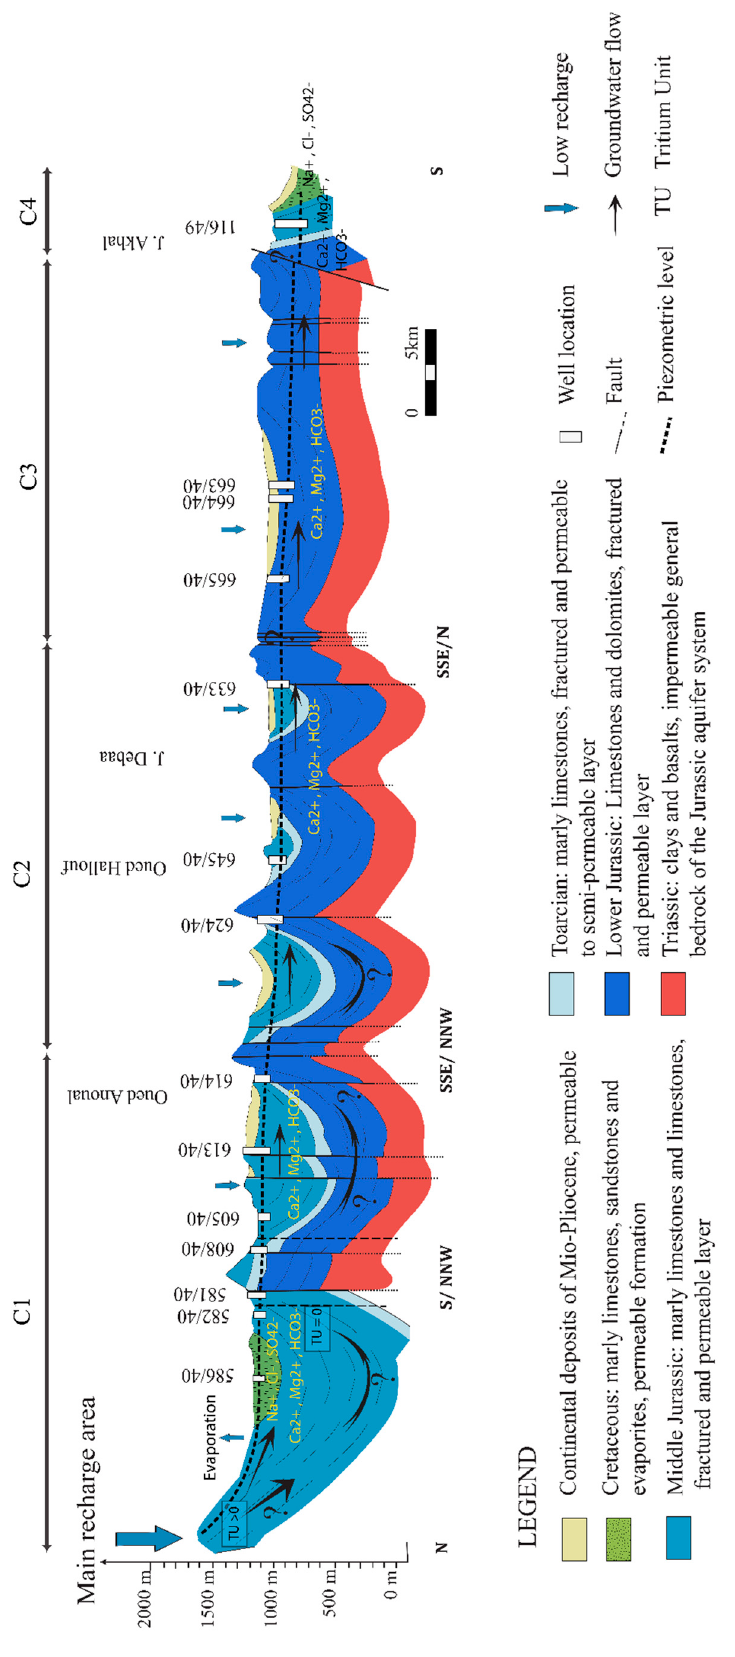
Figure 19. Conceptual model of the East Upper Guir hydrogeological system, based on current available knowledge.